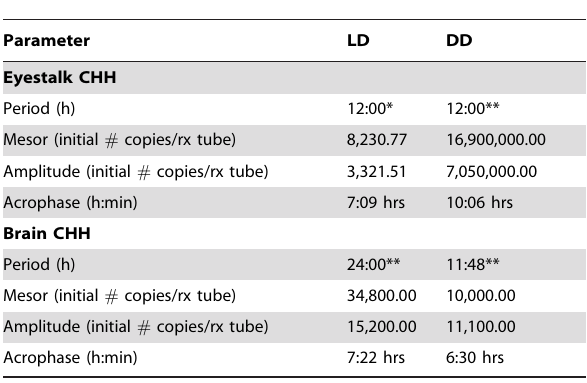
Table 2. Cosinor Analysis.